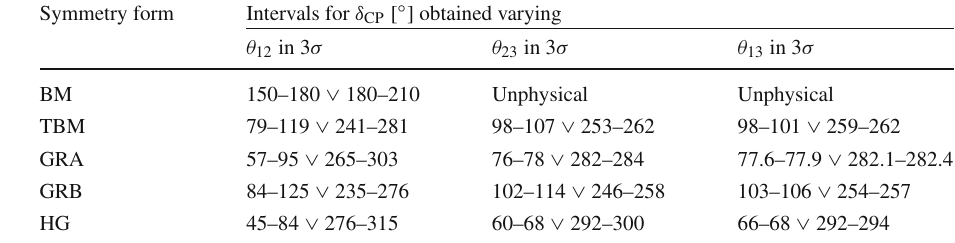
Symmetry form Intervals for δ CP [ ◦ ] obtained varying θ 12 in 3